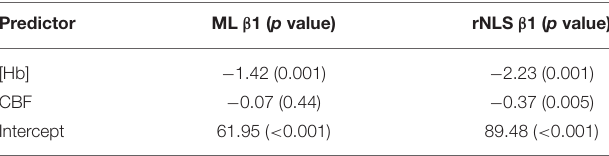
TABLE 3 | Results of a bivariate regression of OEF 0 against CBF 0 and [Hb] for 30 healthy volunteers analyzed with the ML (ensemble of MLPs) and rNLS fitting